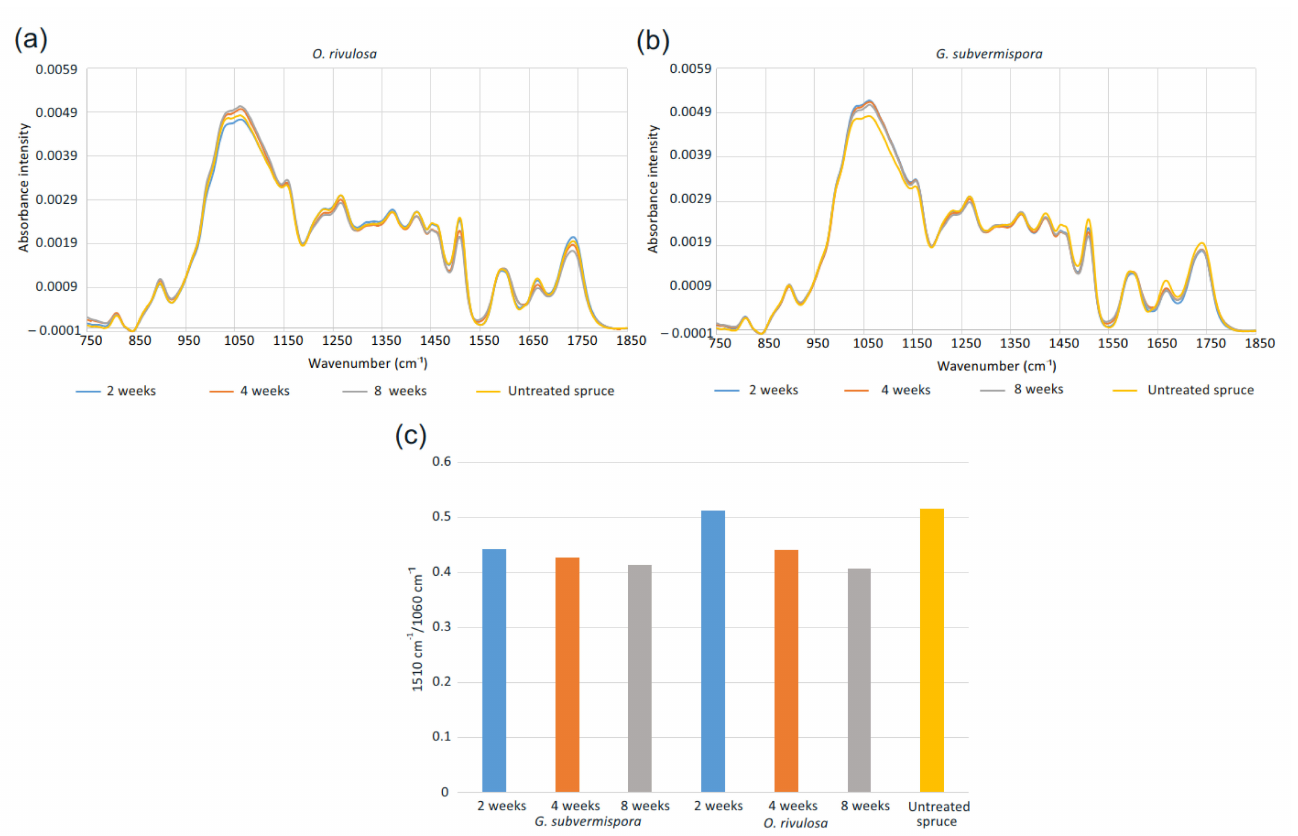
Figure 3. Diffuse reflectance FTIR spectra of Norway spruce wood samples after 2, 4, and 8 weeks of fungal cultivation: ( a ) FTIR spectra after O. rivulosa cultivation, ( b ) FTIR spectra after G. subvermispora cultivation, and ( c ) lignin (1510 cm − 1 )/polysaccharide (1060 cm − 1 )